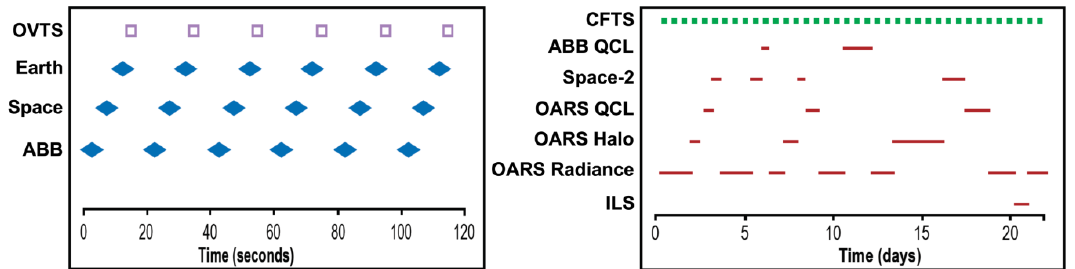
Figure 26. The concept of operations for the ARI instrument on-orbit, over a short-term period of 120 seconds, as shown at left, where the blue diamonds indicate the normal Earth/calibration views and the squares indicate specialized verification and test views. The wide range of OVTS views employed over a long-term period of 22 days is shown at right, where the red lines differentiate OVTS functions from the normal calibration cycle views shown in green.